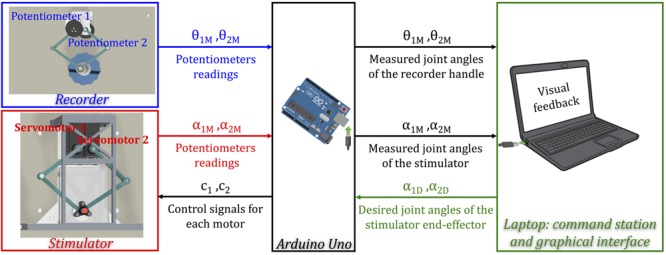
A schematic representation of the control scheme of the Tactile-STAR. An Arduino Uno collects data from the potentiometers integrated into the two devices, and sends the commands to the stimulator servomotors. The laptop receives from the Arduino measurements of the angles from both the recorder and the stimulator, and sends the desired angles to the stimulator. The laptop provides both the graphical interface for the experimenter and online feedback to the participants during the experiment.